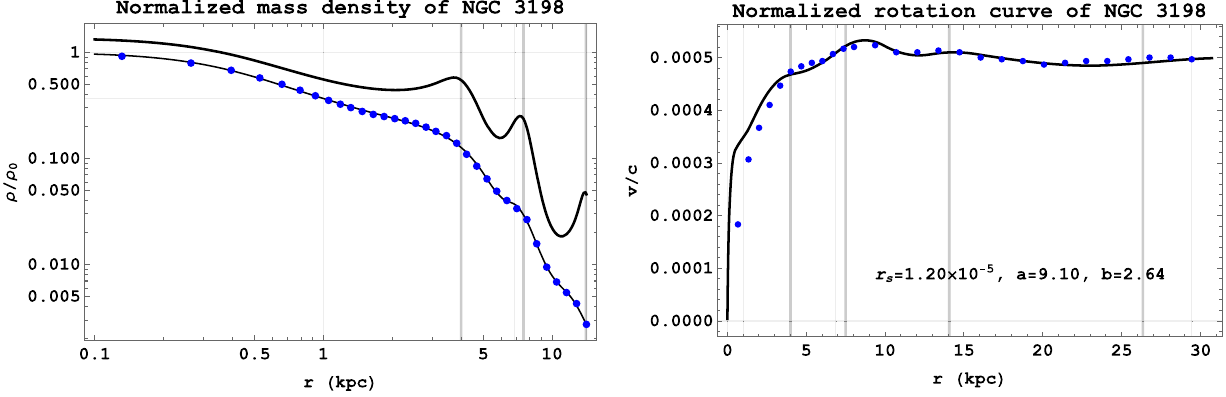
Fig. 7 The thin line in the left-hand side graphic shows the mass den- sity profile fitted to the observed luminosity profile of NGC 3198, listed by Kent [34] and represented by dots. The thick continuous line shows the mass density corrected for the high mass-to-light ratio population. The line in the right-hand side shows the rotation curve fitted to the